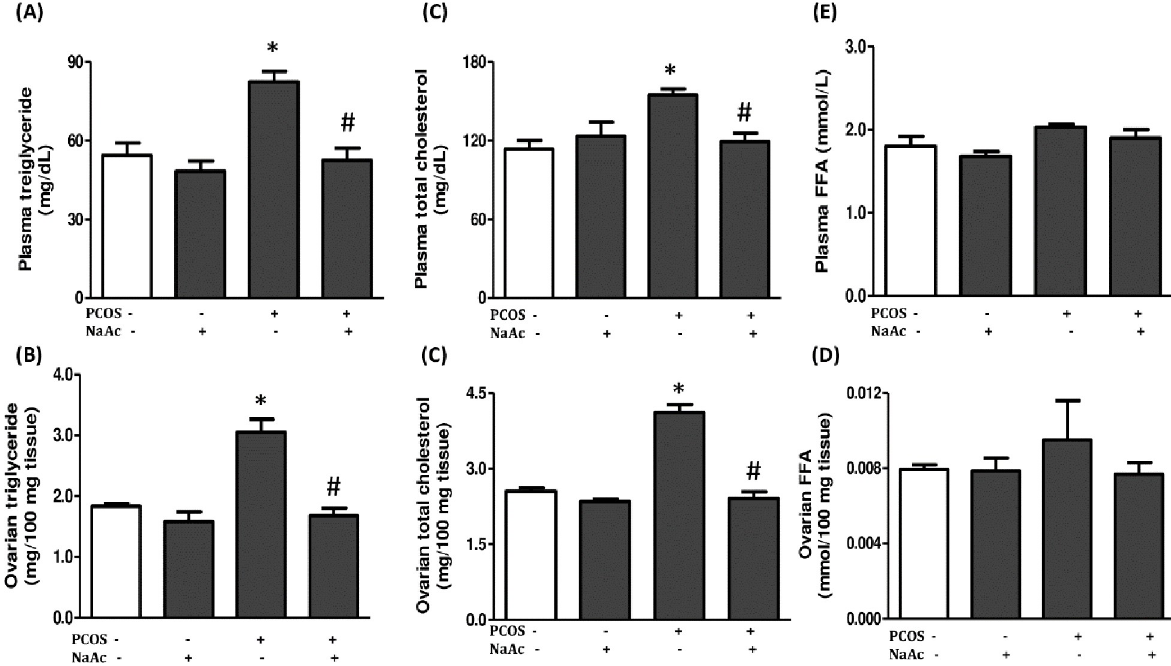
Fig 4. Impact of sodium acetate on plasma and ovarian triglyceride (a, b), total cholesterol (c, d) and free fatty acid (e, f) in LET-induced PCOS rat model. Data are expressed as mean ± SD. n = 6. Data were analyzed by one-way ANOVA followed by Bonferroni post hoc test . ( � p < 0.05 VS. CTL; # p < 0.05 VS. PCOS). Control (CTL); Polycystic ovarian syndrome (PCOS); Sodium acetate (NaAc); Free fatty acid (FFF).